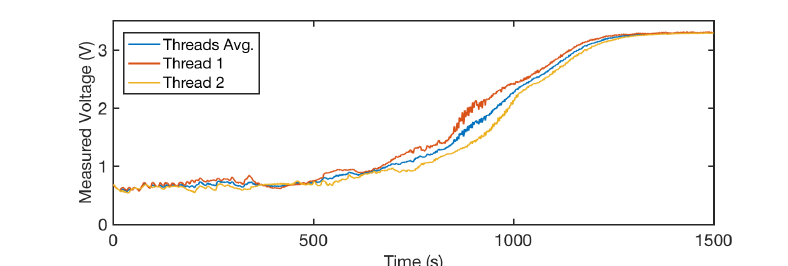
Figure 10. Thread readings during the evaporation process. We show the comparison between individual threads and their average value. The average shows a more stable reading than the single threads. This disparity may be caused by human motion and sensor bending.